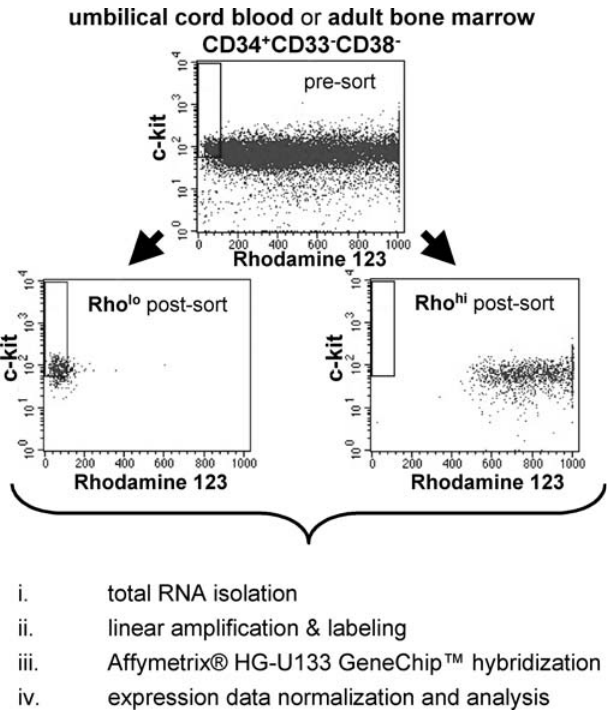
Figure 1. Fluorescence-Activated Cell Sorting and Gene Expression Analysis UCB or adult BM CD34 þ CD33 (cid:1) CD38 (cid:1) Rho lo c-kit þ (Rho lo ; stem cell enriched) and CD34 þ CD33 (cid:1) CD38 (cid:1) Rho hi (Rho hi ; stem cell depleted) cell populations were sorted for subsequent global gene expression profiling. Total RNA was isolated from Rho lo and Rho hi cell populations prior to linear amplification and labeling for hybridization to the Affymetrix HG-U133 GeneChip set (approximately 45,000 probe